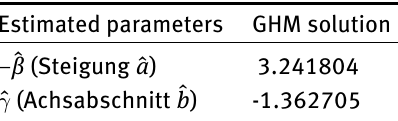
Table 2: Results from [13]